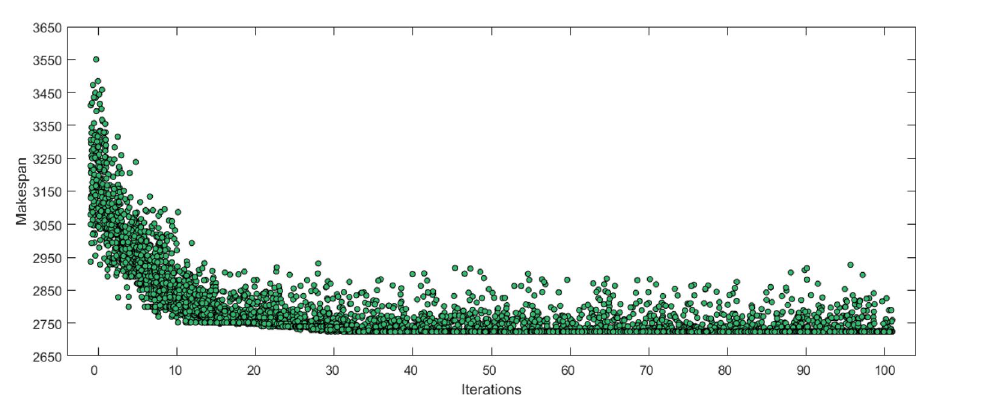
Figure 12. Individual distribution map of NEH-SGA on